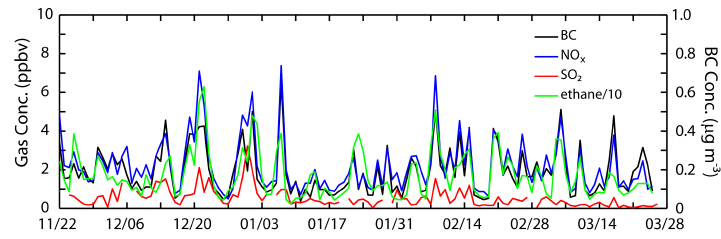
Figure 13. Timeline of ethane, NO x , SO 2 , and BC during the second study period in 2013–2014. NO x , SO 2 and BC concentrations are daily average values; ethane data are the average of two grab samples per day, one collected in the morning and one collected in the